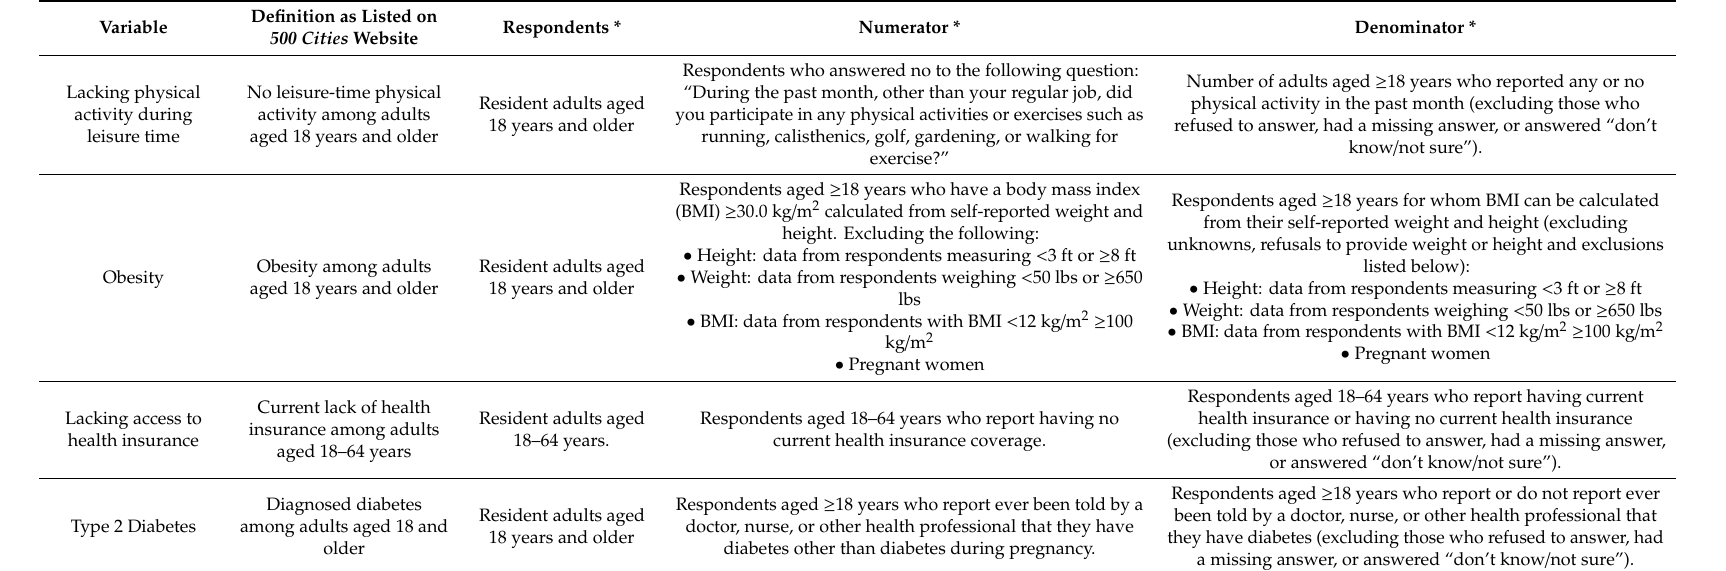
Table A1. Definitions of variables examined in regression analyses